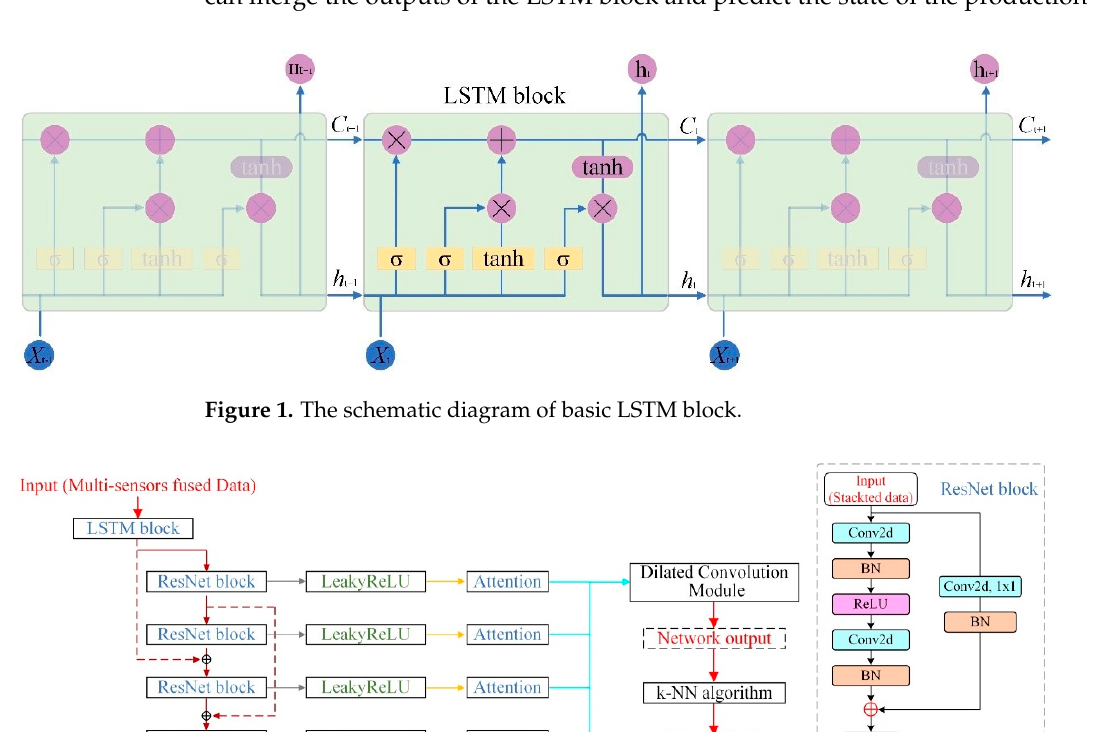
Figure 1. The schematic diagram of basic LSTM block.